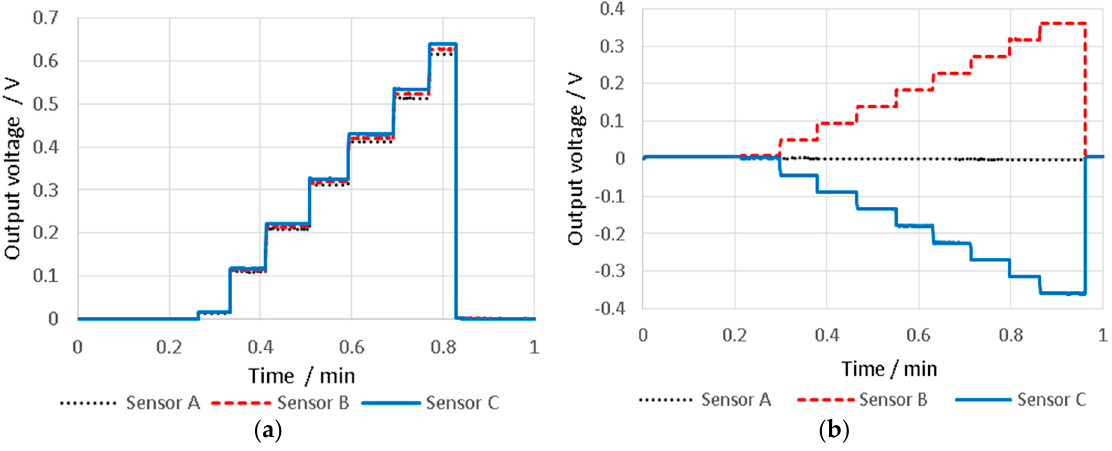
Figure 14. Output voltage from three capacitive sensors against the displacement of the probe tip in ( a ) z direction and ( b ) y direction, which are equal to 1 µm to generate probe calibration in vertical ( a ) z direction and ( b ) y direction, which are equal to 1 µ m to generate probe calibration in vertical and and lateral direction, respectively. lateral direction,